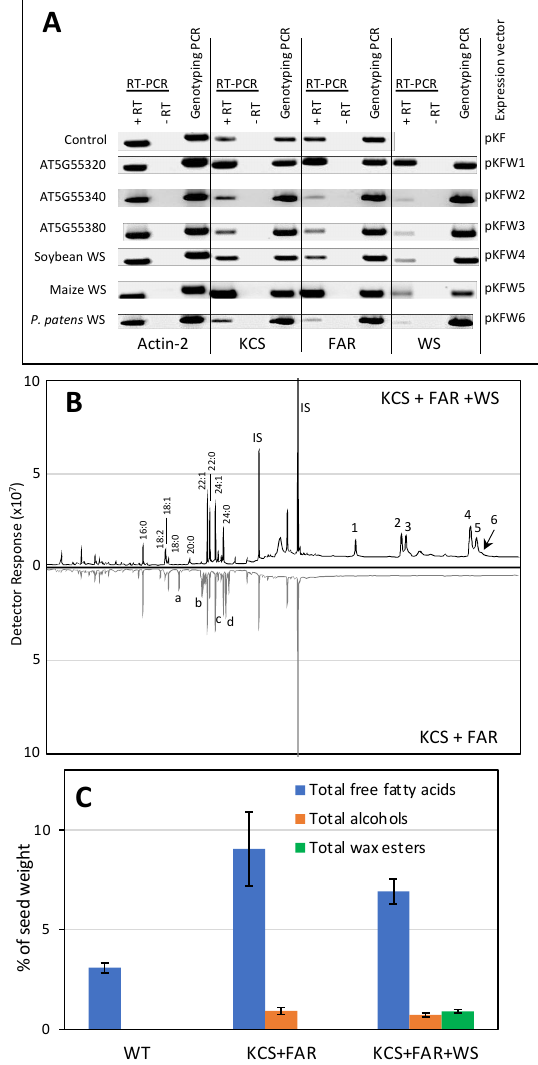
Figure 4. Characterization of WS expressed in Arabidopsis seeds. ( A ) RT-PCR and genotyping PCR of transgenic Arabidopsis plants transformed with the expression vectors pKF (control) and pKFW1-pKFW6. Each of these vectors, except pKF, co-expressed the jojoba KCS, jojoba FAR and each of indicated WS transgenes. RNA isolated from Arabidopsis seeds was used as a template in RT-PCR to confirm the expression of each indicated transgene, and the expression of the Arabidopsis actin-2 gene was used as a positive control. Control reactions that were not treated with reverse transcriptase (-RT) confirmed that the visualized bands were derived from the mRNA template. In parallel, DNA isolated from the seeds was used to conduct genotyping PCR, which confirmed the presence of each transgene. The identity of each PCR product was confirmed by direct sequencing; ( B ) GC profiles of lipids extracted from Arabidopsis seeds transgenically co-expressing the jojoba KCS and jojoba FAR, with (upper profile) or without (lower profile) the transgenic WS encoded by At5g55380.